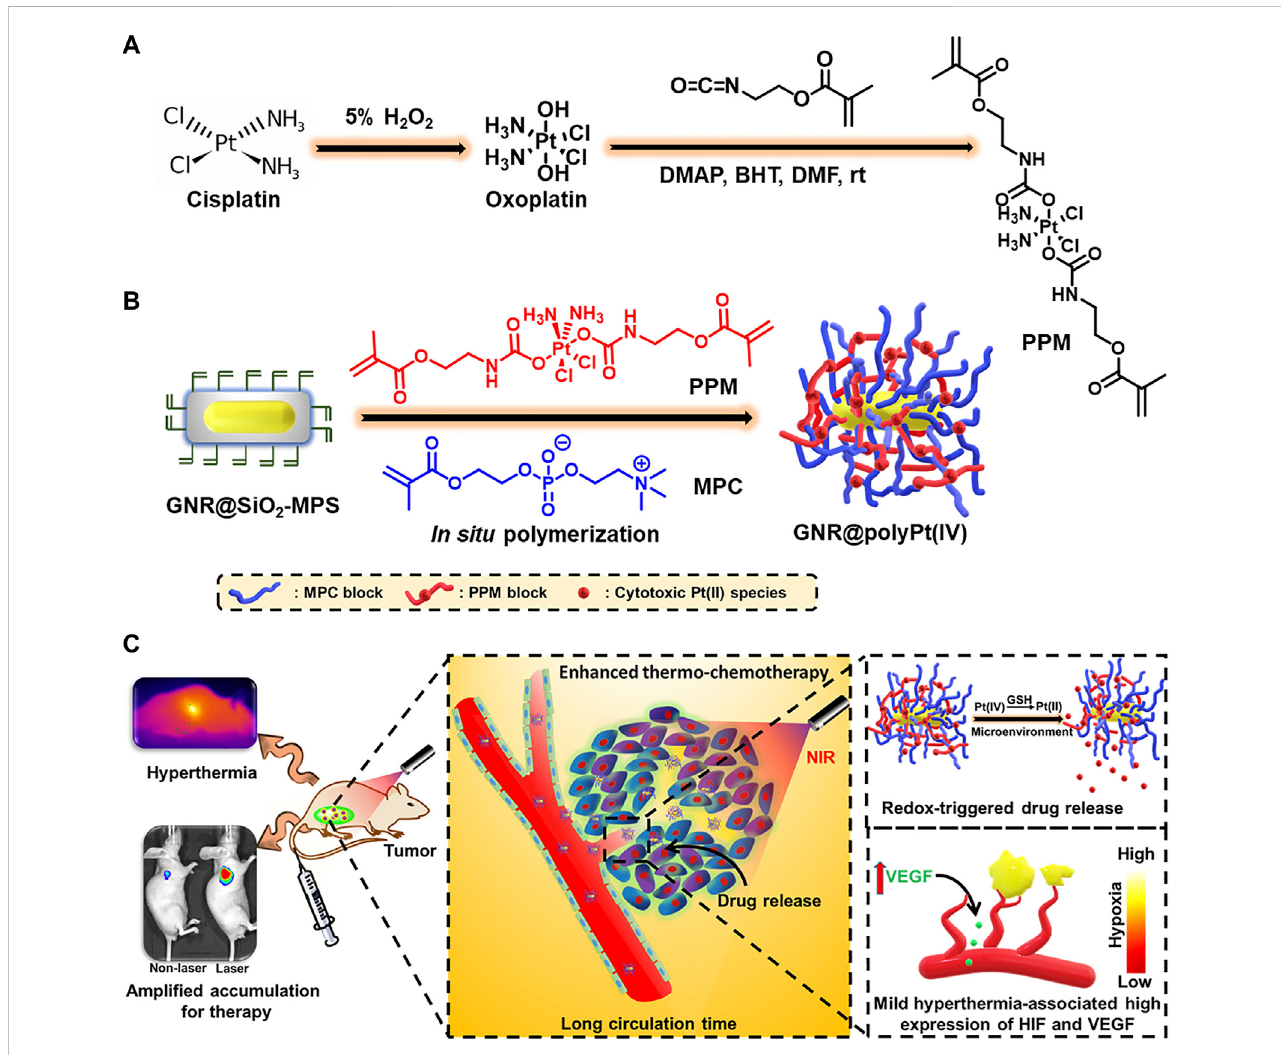
FIGURE 2 Illustration of the redox-responsive, in situ , polymerized GNR@polyPt (IV) for enhanced thermo-chemotherapy. (A) The synthesis of Pt (IV)-based prodrug monomer. (B) The preparation of GNR@polyPt (IV). (C) Schematic illustration of GNR@polyPt (IV) with redox-triggered drug release and mild- hyperthermia-ampli fi ed tumor penetration for enhanced thermo-chemotherapy of cancer. Reproduced with permission from (Guo et al., 2021) Copyright (2020)